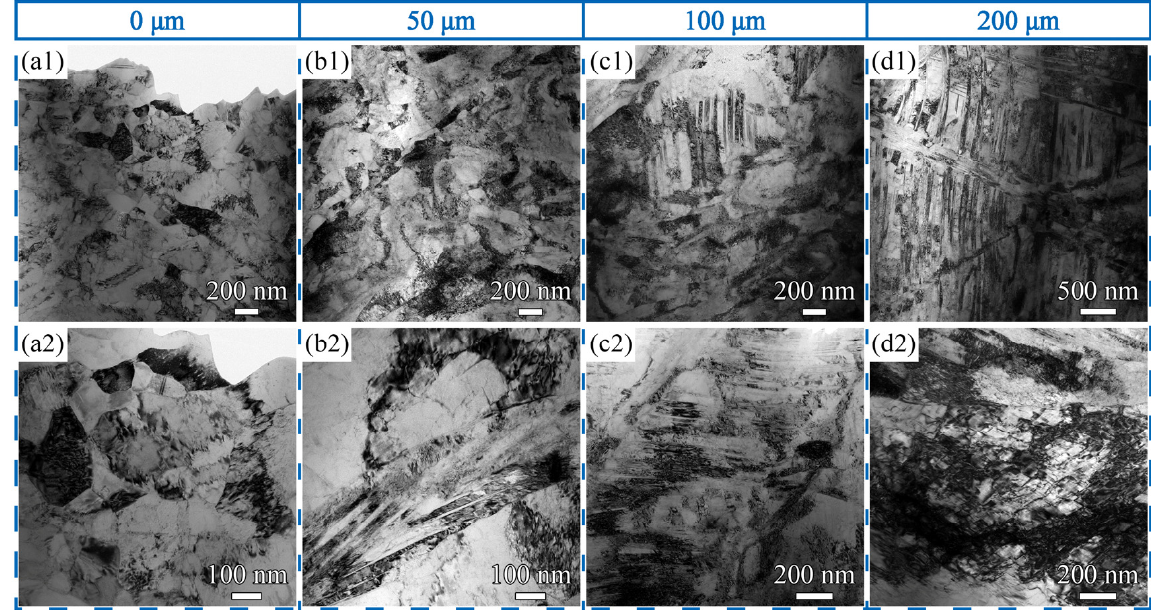
Figure 4. Typical longitudinal section TEM images of the SS-USSR sample at depth of ( a1 ) 0 μ m; ( b1 ) 50 μ m; ( c1 ) 100 μ m; and ( d1 ) 200 μ m. ( a2 – d2 ) are high-magnificent image corresponding to the depth of 0 μ m, 50 μ m, 100 μ m, and 200 μ m, respectively.